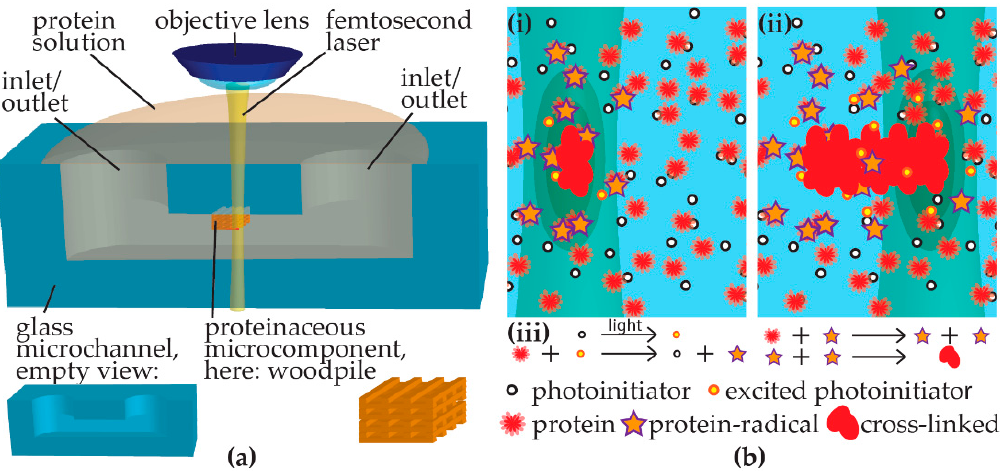
Figure 1. Schematic illustration of concept of proteinaceous microcomponent integration inside a closed microfluidic channel. ( a ) Illustration shows a three-dimensional (3D) glass microchannel with inlet and outlet, covered and filled with a drop of protein solution. A femtosecond laser is focused into the solution in the channel by an objective lens. Inside the channel, along the relative movement of the laser focus, protein is cross-linked to form a 3D proteinaceous microcomponent. As demonstration, we fabricate woodpile structures; line arrays that rotate by 90° every consecutive layer. The objective lens is simultaneously used for in situ observation with a charged couple device (CCD) camera. ( b ) Illustration of protein cross-linking initiated by the two-photon excitation of a photoinitiator along the relative laser movement from ( i ) to ( ii ). ( iii ) Excited photoinitiator induces the radicalization of the protein and the generated protein radicals cause further radicalization, some of which eventually cross-link with proximate other protein radicals to growingly form the 3D proteinaceous component.